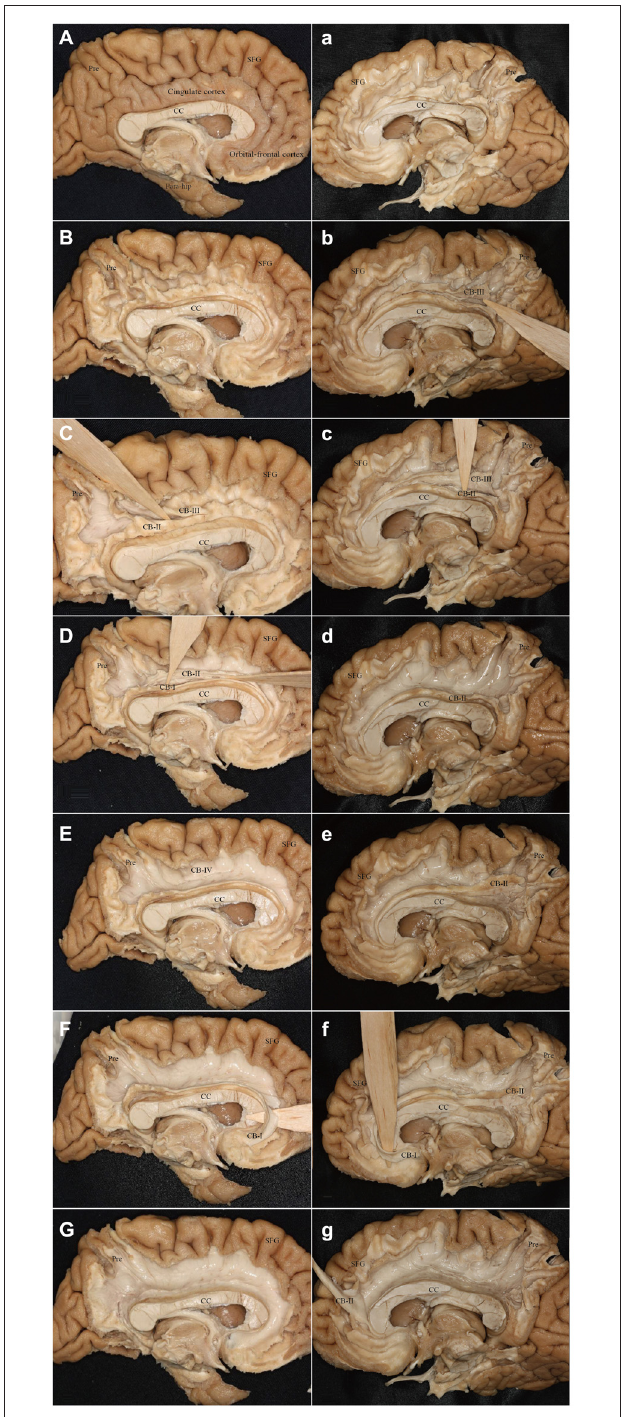
FIGURE 10 | Step-by-step fiber dissection of the CB (one left hemisphere and one right hemisphere). (A) Medial surface of the left hemisphere after removing of vessels, arachnoid and pia-matter. (B) Removing the cortex within the depth of the sulci only, with preservation of the cortex of the hemispheres surface of the gyri. (C) Identifying the CB-III fibers that originate from the precuneus and extend above the CC. (D)